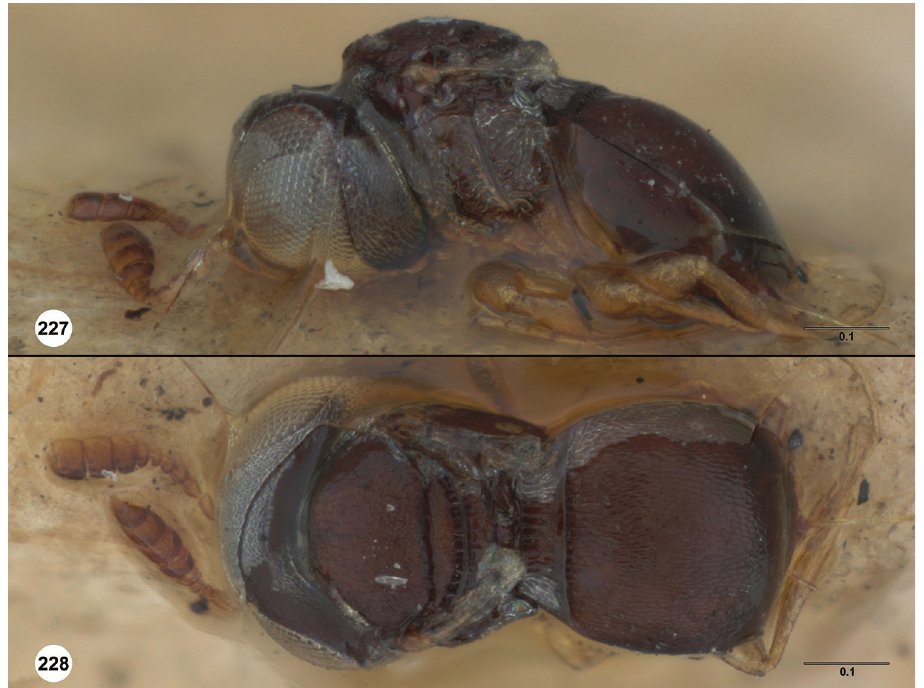
Figures 227–228. Phanuromyia biroi , female paratype (Hym.Typ.No. 4611, Mus.Budapest) 227